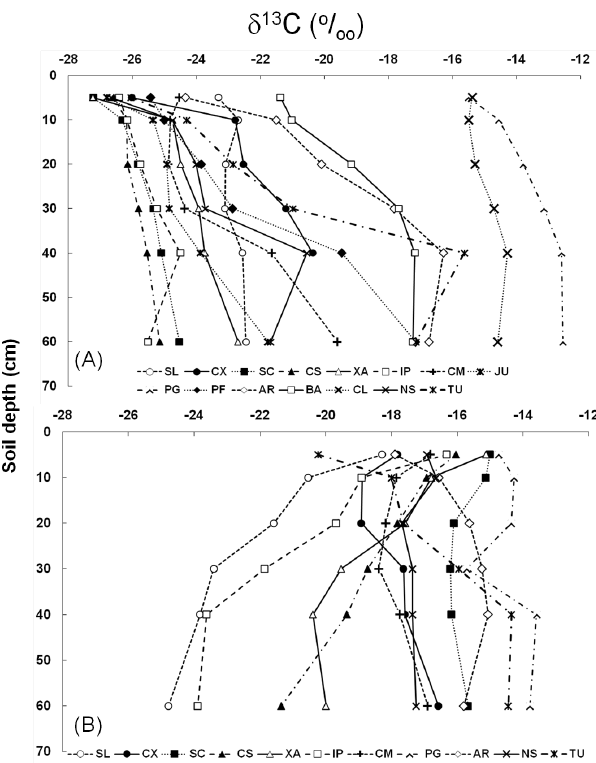
Fig. 2. Variability of δ 13 C of soil organic matter with soil depth of native forests (A) and pastures of the paired study sites (B) . Legends are name abbreviations of sampling sites according to Table 1.